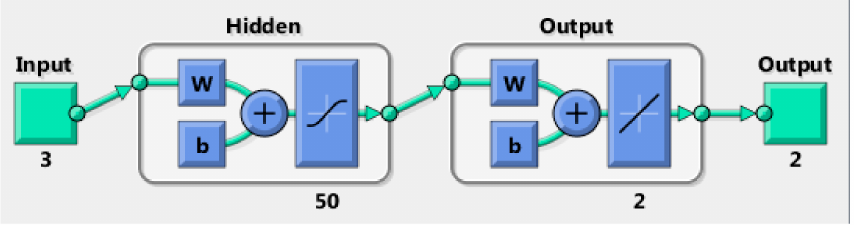
Figure 12. Structure of the ANN used for fitting the simulation